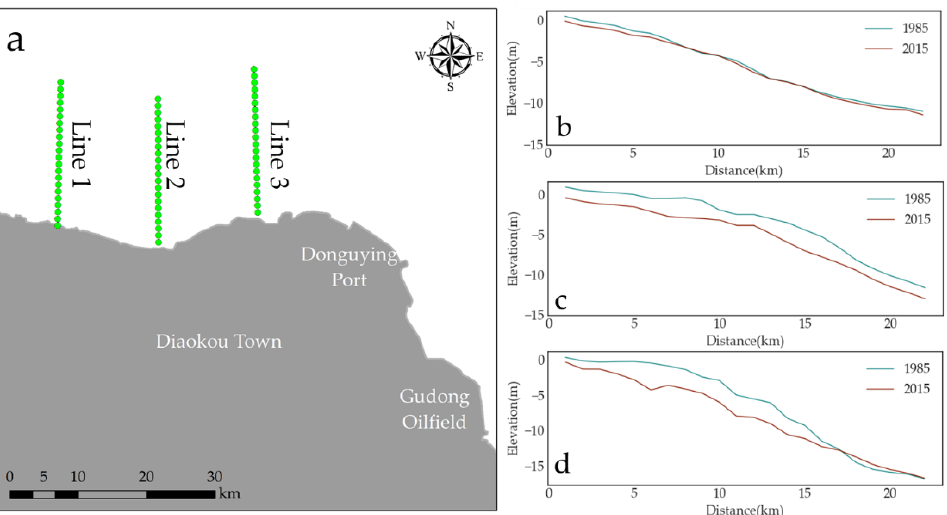
Figure 17. Bathymetric profiles of three cross-sections at Diaokou. (( a ): Locations of cross-sections; ( b ): Line 1; ( c ): Line 2; ( d ): Line 3).